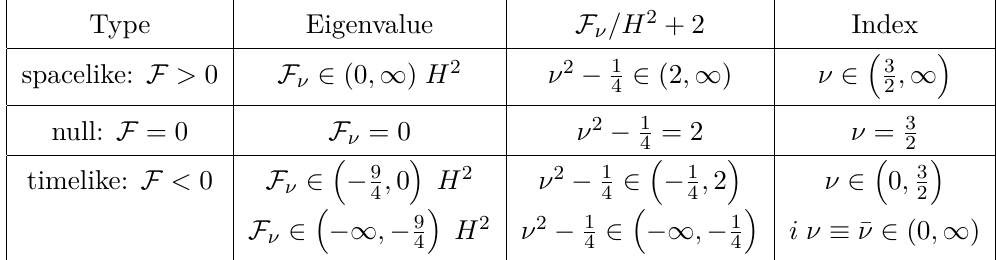
Table 1. The types of eigenvalues of − 2 on de Sitter